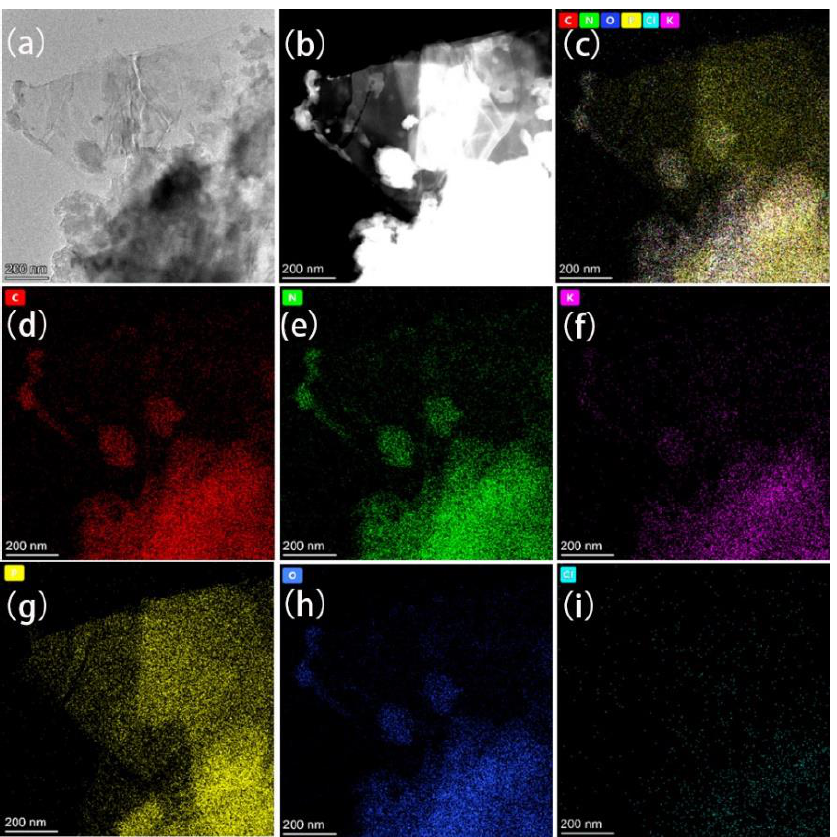
Figure 2. ( a ) TEM image of 10%BP/KPHI; ( b ) Dark field TEM image of 10%BP/KPHI; high-angle annular dark-field TEM element mapping images of 10%BP /KPHI catalyst. ( c ) all elements, ( d ) for C, ( e ) for N, ( f ) for K, ( g ) for P, ( h ) for O, and ( i ) for Cl.